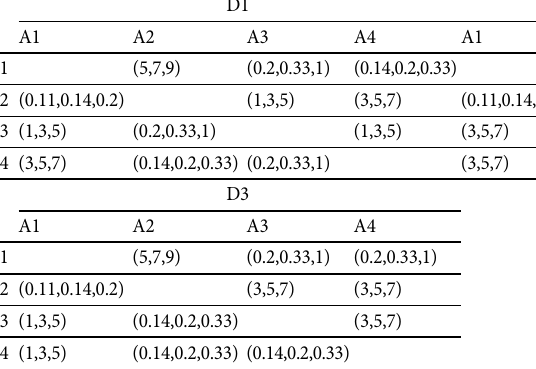
Table 9. Converted fuzzy numbers of DMs’ evaluations for alternatives D1 D2